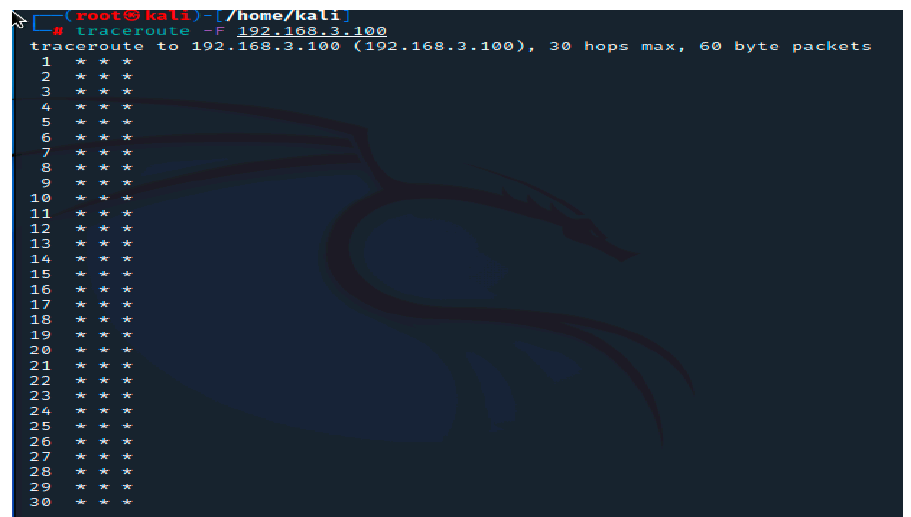
Figure 5. Traceroute result.